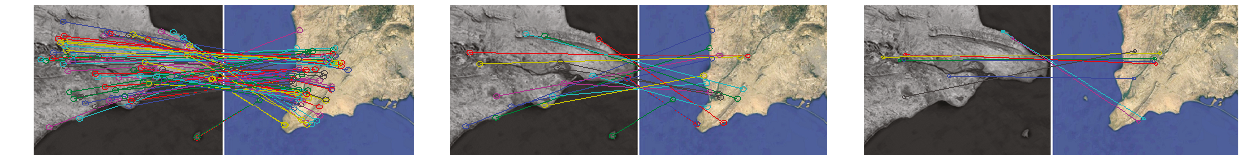
Figure 22: Coastline landmark registration result with SURF, PCA-SURF, and